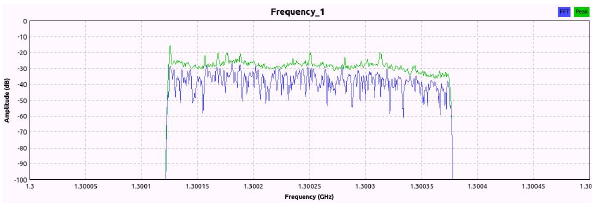
Figure 6. Secondary user receives at 1.30025GHz.